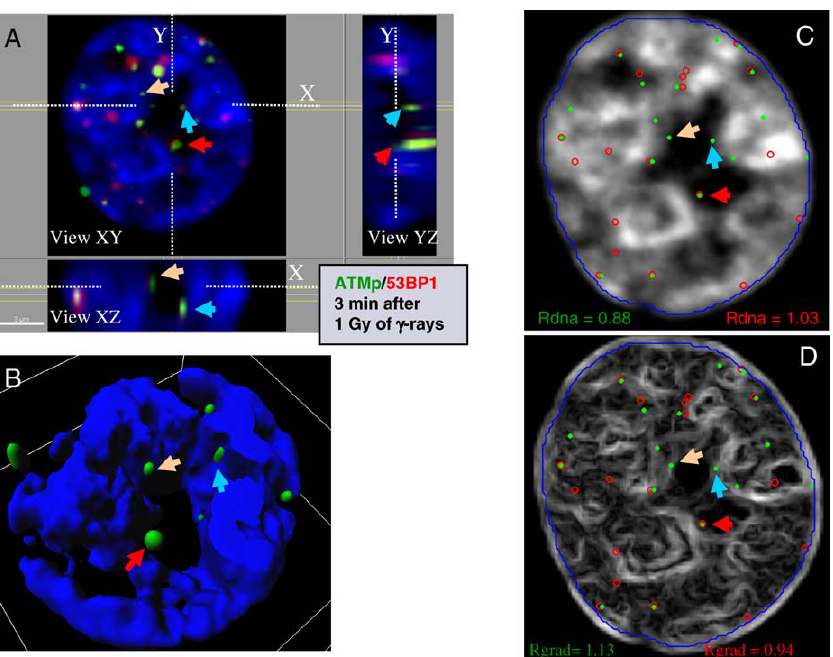
Figure 8. Representative RIF Distribution Following Low-LET Radiation Exposure DAPI is shown in blue, ATMp in green, and 53BP1 in red. (A) shows a representative 3-D image of a nucleus in orthogonal cross-section views. The same nucleus is seen in (B) as a 3-D surface rendering with only DAPI and ATMp RIF being segmented (i.e., blue and green surfaces, respectively; rendering done with Bitplane). This nucleus clearly shows the preferred location of ATMp RIFs at the interface between high and low DNA density regions. Different ATMp RIFs located at these interfaces are shown by colored arrows. (An arrow of the same color represents the same focus.) (C) and (D) overlay the identified locations of ATMp and 53BP1 RIFs (green disk and red circles, respectively) with the DAPI intensity and gradient images, respectively. Rdna and Rgrad values are given for each panel with colored text corresponding to the protein. One can see in (D) that the green RIFs shown by arrows are along high-gradient contours, which are reflected by a high Rgrad value. In contrast, the red RIF seem to locate themselves fairly randomly over the full nucleus, as reflected with Rdna and Rgrad values close to 1.